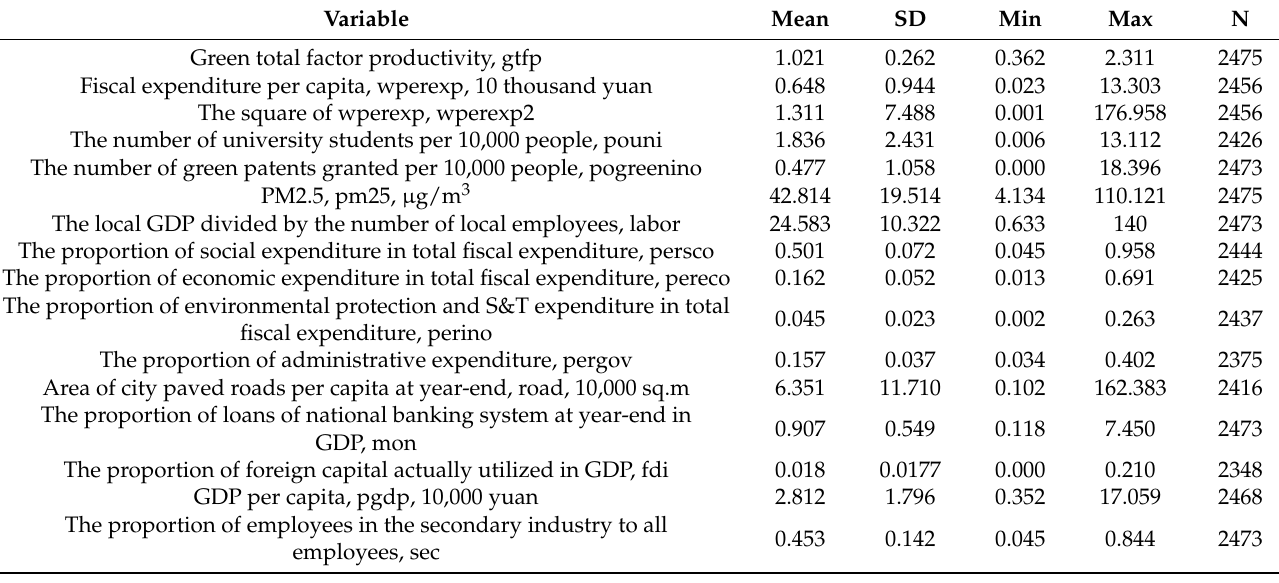
Table 5. Variables used in the empirical analysis and their